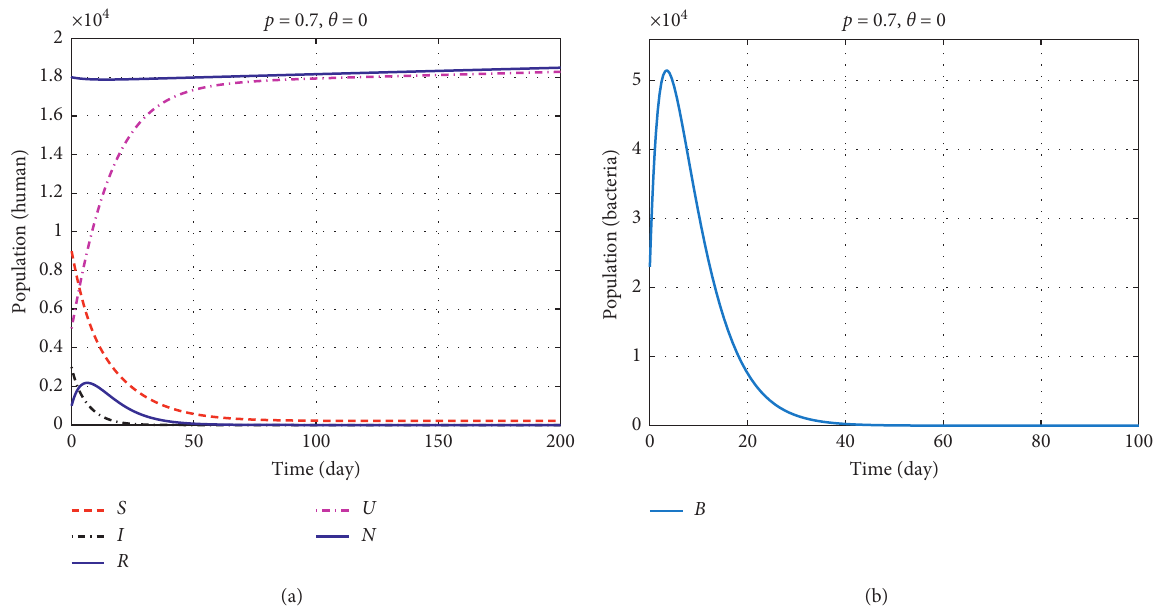
Figure 4: Time series solution of individual (a) and bacteria (b) cohorts when p � 0 . 7 and θ � 0. The diseases die out ( R